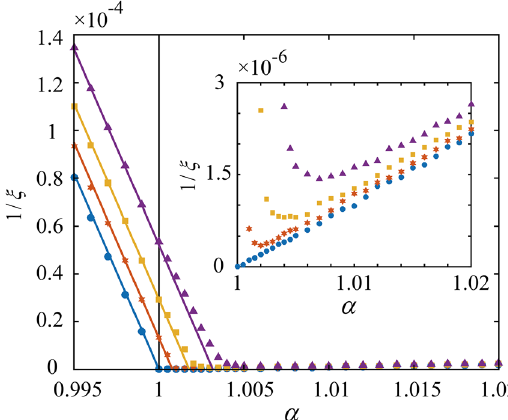
Figure 5: (Color online) The plot of inverse localization length 1 / ξ as a function of α at different incident angles. The blue circles, red hexagrams, yellow squares and purple triangles denote numerical resultsfor sin θ 0 = 0, 0.04, 0.06 and0.08, respectively. The straight lines are the results of Eq. (30). The α = 1 is marked by a black solid line. The inset shows the details at small values of 1 / ξ in the region of α ≥